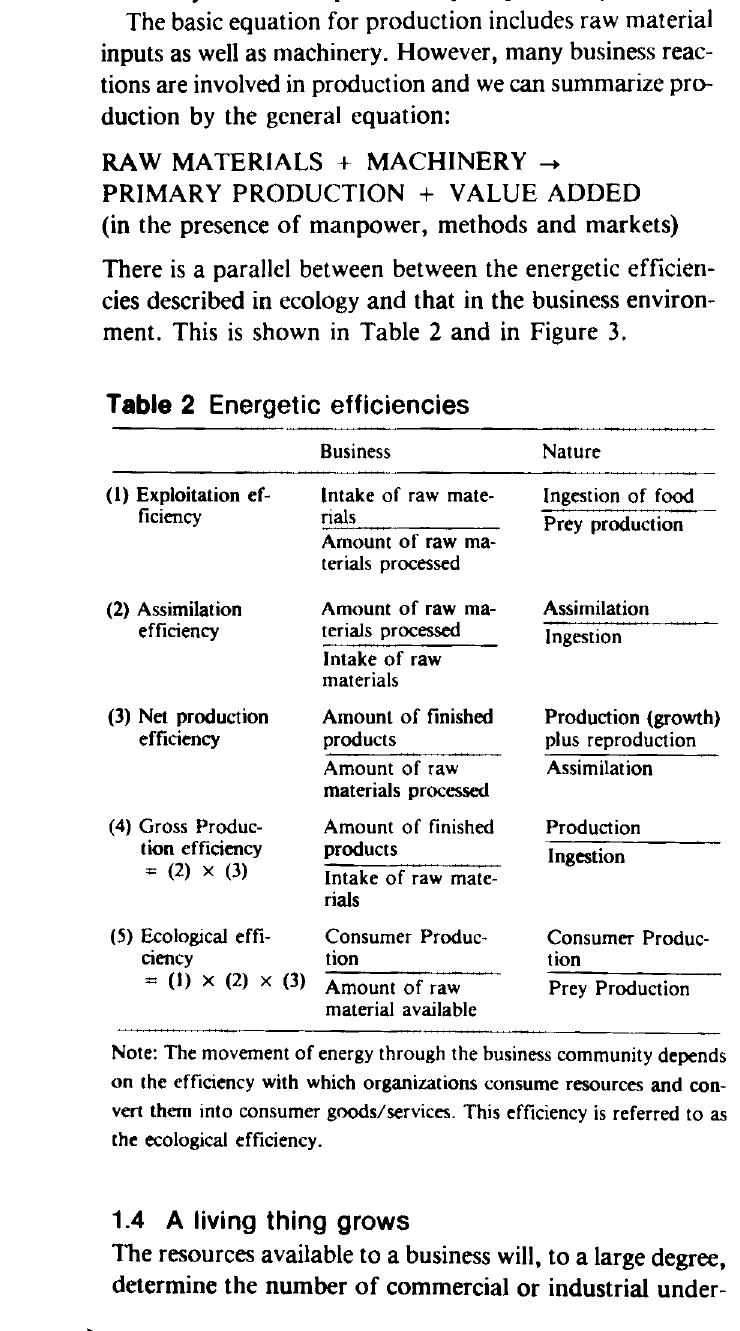
Figure 3 Business metabolism and energetic